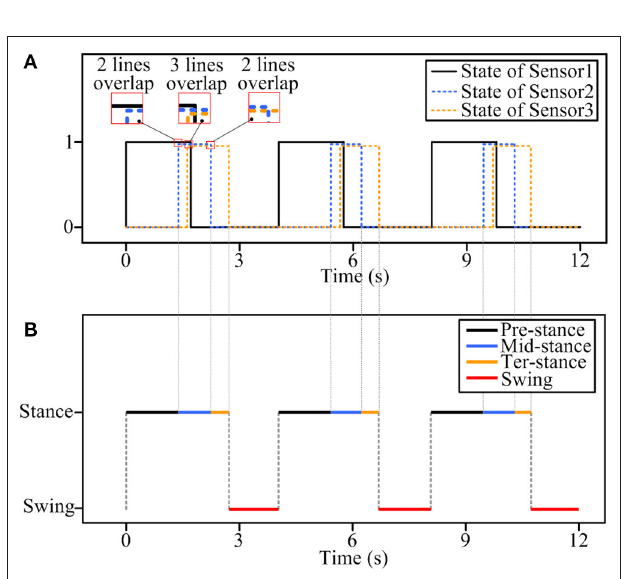
FIGURE 5 | The gait phase classification process, (A) 0 and 1 states of the thin-film pressure sensor, (B) gait sub-phase